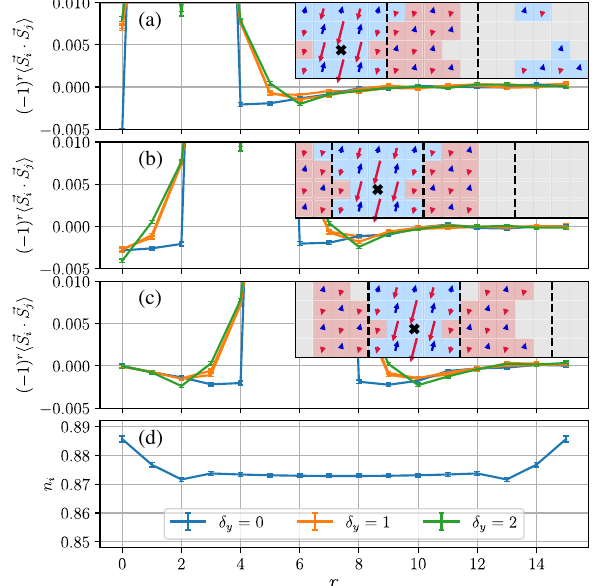
max ¼ FIG. 14. Observation of incommensurate spin correlations at U=t ¼ 6 , p ¼ 1 = 8 , t 0 =t ¼ − 0 . 25 , and T=t ¼ 0 . 22 on the 16 × 4 cylinder. (a) – (c) Staggered spin correlations for three different reference sites. δ y denotes the offset in the y direction. The insets show the sign structure of the staggered spin correlations. The spin correlation is considered to have positive or negative sign if it is nonzero by 2 standard deviations. (d) Number density n i along the length of the cylinder. Our results confirm the findings presented in Fig. 4 of Ref.